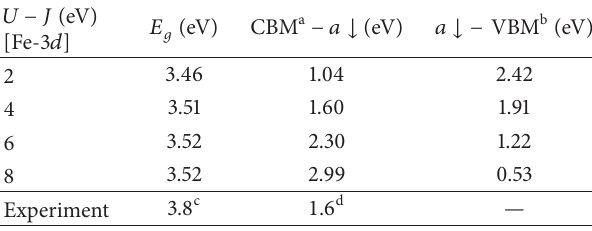
a Conduction band maximum. b Valence band maximum. c Reference